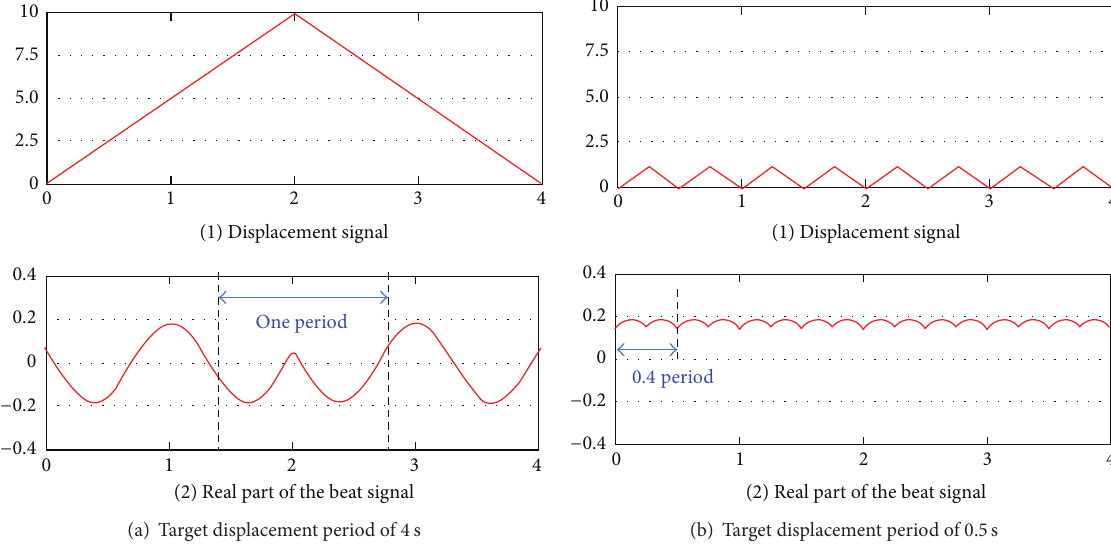
Figure 6: The target displacement and real part of the beat signal.